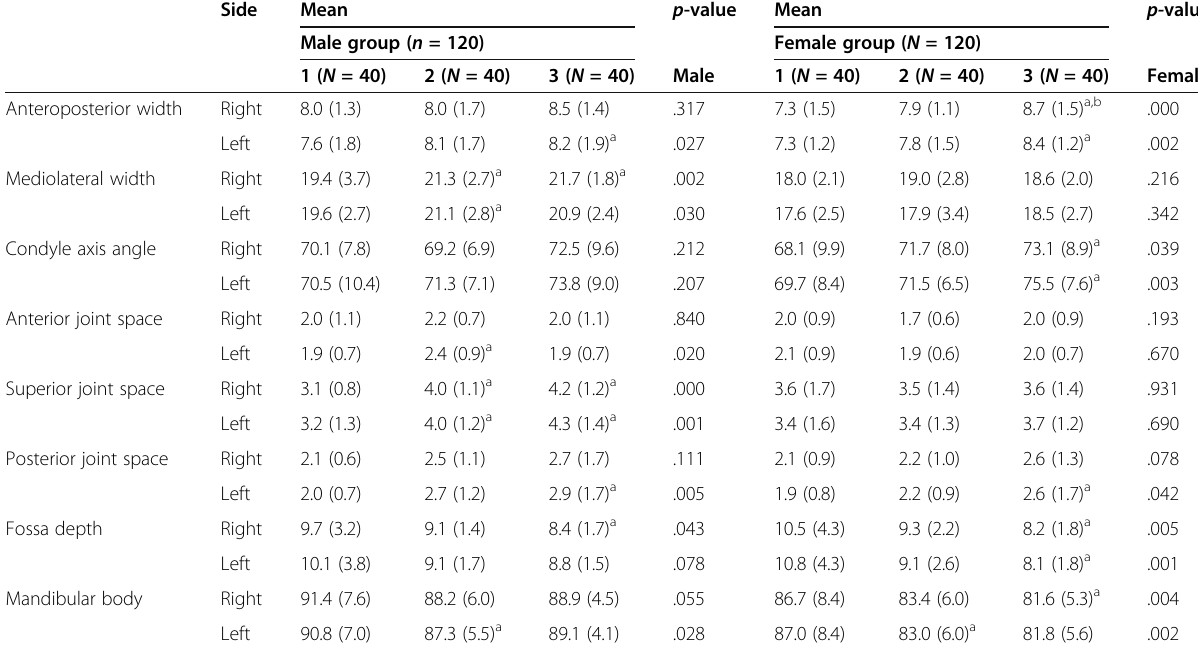
Table 4 Table comparing gender and right/left side based on ages and Bonferroni test of dependent variable among different age groups